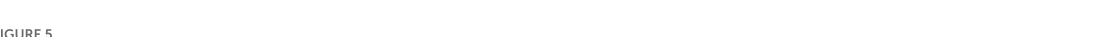
FIGURE5 the myocardial hypertrophy markers alpha smooth muscle actin ( α SMA) (Ic) and beta myosin heavy chain ( β -MHC) (Id) was significantly higher in the left ventricle of 3-month-old MYH6-Cre-BDNF − / − mice. Moreover, compared to those in WT mice, the metabolism-related parameters, serum levels of BDNF and insulin in 3-month-old MYH6-Cre-BDNF − / − mice were significantly increased (IIIa,b) . n = 3 for the WT and MYH6-Cre-BDNF − / − groups respectively in (Ia,b) ; n = 4 for the WT and MYH6-Cre-BDNF − / − groups respectively in (IIa) ; n = 11 for the WT and MYH6-Cre-BDNF − / − groups respectively in (IIb) ; n = 6 for the WT and MYH6-Cre-BDNF − / − groups respectively in (IIc) ; n = 6 for the WT and MYH6-Cre-BDNF − / − groups respectively in (IIIa) ; n = 7 for the WT and MYH6-Cre-BDNF − / − groups respectively in (IIIb) ; n = 9 and 7 for the WT and MYH6-Cre-BDNF − / − groups respectively in (IIIc) ; n = 5 for the WT and MYH6-Cre-BDNF − / − groups respectively in (IIId) . (IV–VI) After MI, the LVEF and LVFS of 5-month-old MYH6-Cre-BDNF − / − mice were significantly smaller than those of WT mice (IVa,b) . While the LVIDd, LVIDs, LVEDV, and LVESV were not statistically significant compared to those in WT mice (IVc–f) . In parallel, the infarct size of MYH6-Cre-BDNF − / − MI hearts were significantly larger than that of WT hearts (V) . In addition, the smallest ventricular wall thickness of the infarct zone and the thickness of the infarct border zone of MYH6-Cre-BDNF − / − MI hearts were significantly smaller than those of wild-type MI hearts (VI) . n = 8 and 6 for the WT and MYH6-Cre-BDNF − / − groups respectively in (IV–VI) . LVEF, Left ventricular ejection fraction; LVFS, Left ventricular fractional shortening; LVIDs, Left ventricular end-systolic internal diameter; LVIDd, Left ventricular end-diastolic internal diameter; LVESV, Left ventricular end-systolic volume; LVEDV, Left ventricular end-diastolic volume; MYH6-Cre-BDNF − / − , Cardiomyocyte-derived BDNF conditional knockout. * p < 0.05, ** p < 0.01, *** p <